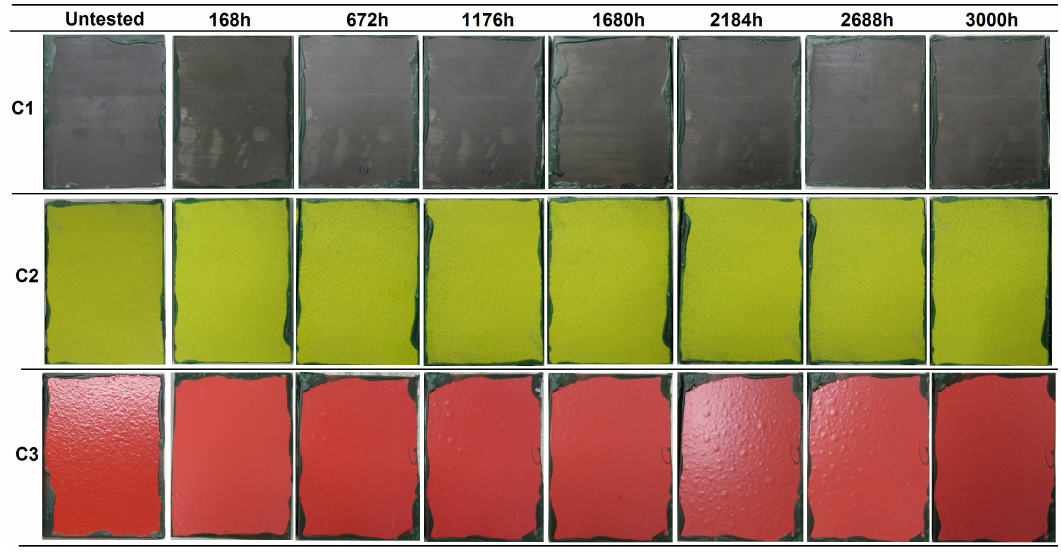
Figure 2. Visual appearance of the R4-coated samples at different evaluations during the immersion test in accordance with the ISO 2812 standard. test in accordance with the ISO 2812 standard.